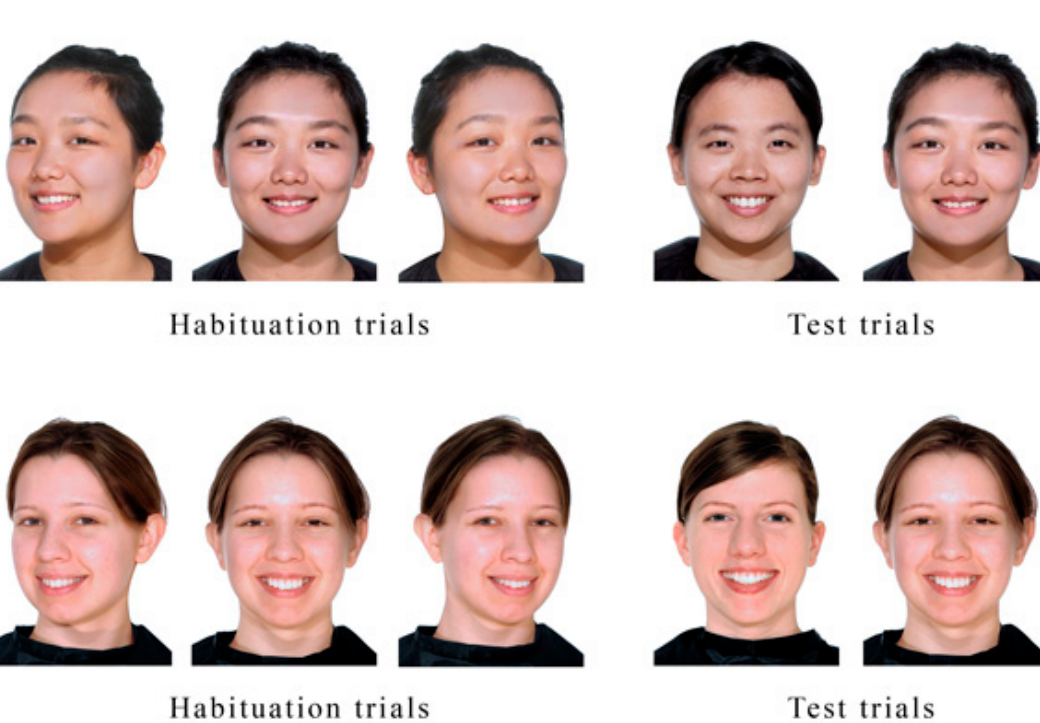
Figure 1. Examples of other-race (above) and same-race (below) faces used in the habituation and test trials. We are authorized to use and publish the photographs of the person in the figures.